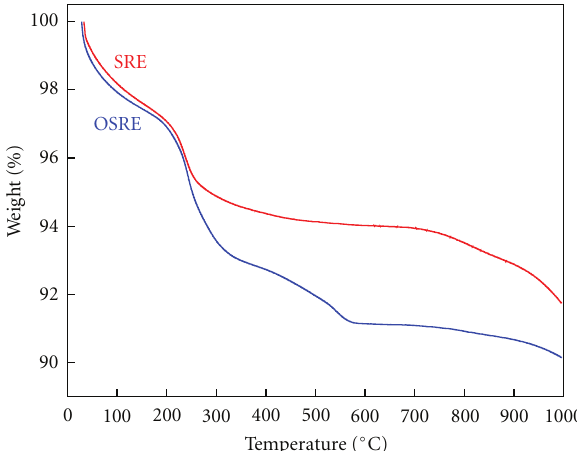
Figure 4: TG curves of used catalyst after SRE and OSRE